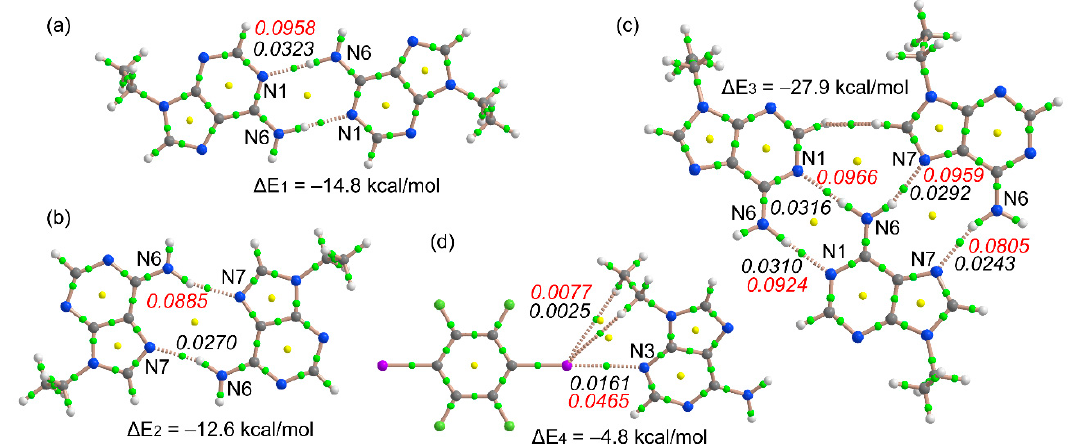
Figure 6. Distribution of bond and ring critical points (green and yellow spheres, respectively) and bond paths in the DFT-D optimized Watson–Crick dimer ( a ), the Hoogsteen dimer ( b ), the trimer ( c ), and the X-bonded dimer ( d ). The values of ρ (r) and its Laplacian [ ∇ 2 ρ (r)] at the bond critical points are indicated in italics (a.u.) using black and red font, respectively.